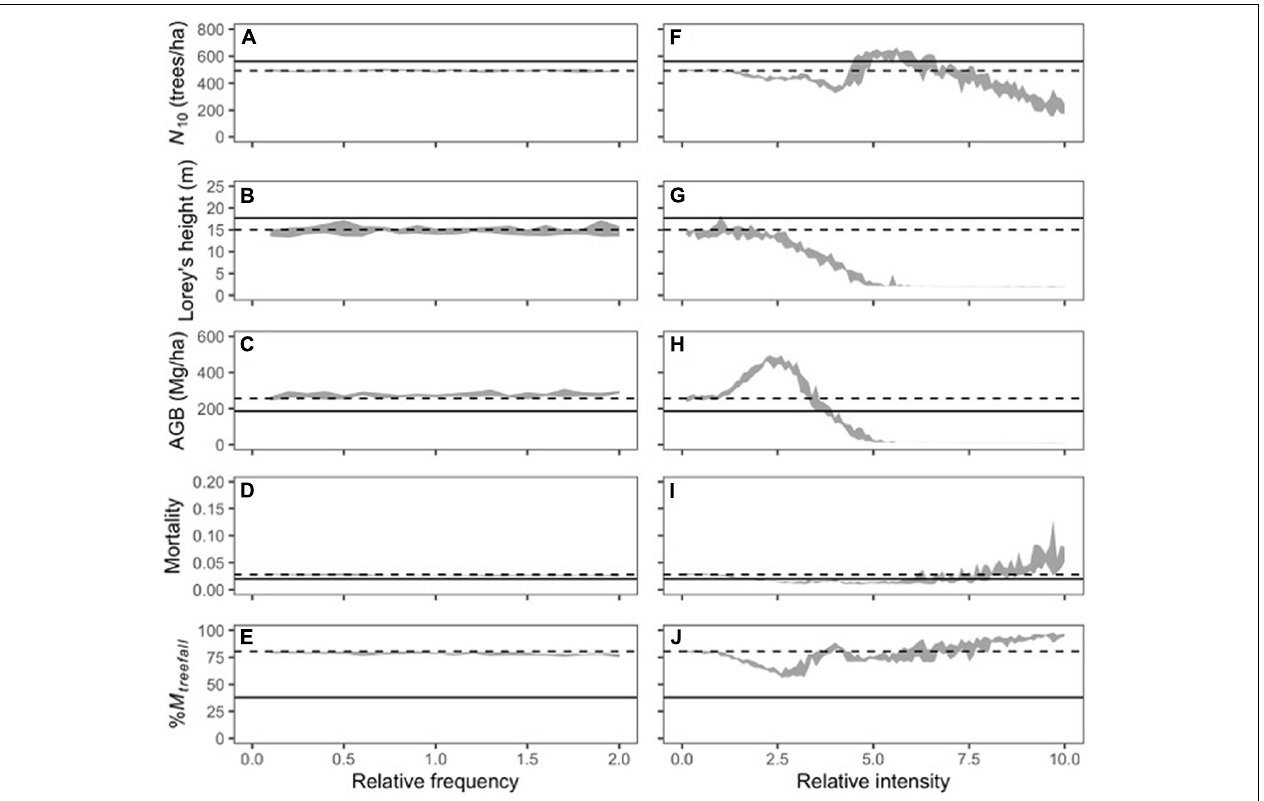
FIGURE 3 | Simulated forest structure in relation to extreme wind frequency (A–E) and intensity (F–J) , relative to empirical values from cyclone best-track data. For simulations with varying frequency, empirical wind intensity were used, and vice versa. Shaded areas represent the value ranges of five replicates for each simulation condition. (A,F) N 10 , density of stems with DBH > 10 cm (trees ha − 1 ). (B,G) Lorey’s height, basal area-weighted mean tree height (m). (C,H) AGB, aboveground biomass (Mg ha − 1 ). (D,I) mean annual mortality rate. (E,J) % M treefall , fraction of mortality due to treefalls. Dashed lines represent simulation value with no wind disturbance, and solid lines represent field